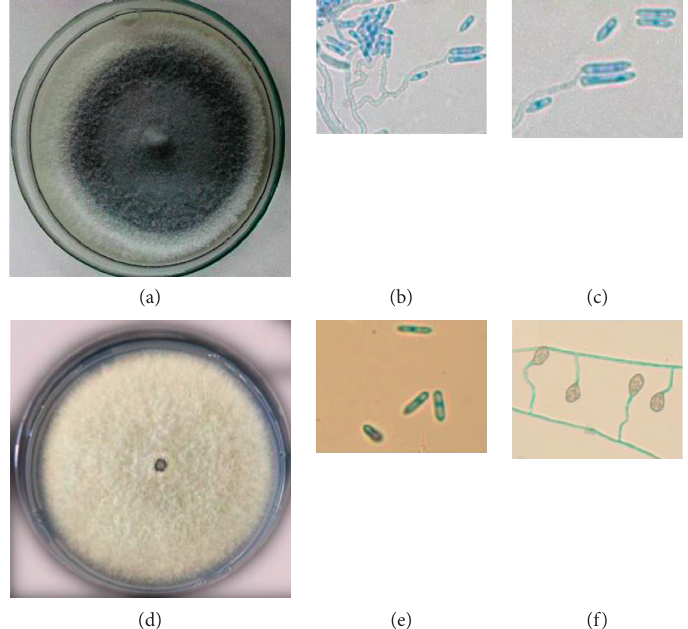
Figure 1: Morphology of the microorganisms used. (a) Morphology of the Colletotrichum siamense colony on potato dextrose agar (PDA). (b, c) Hyphae and conidia of C. siamense . (d) Morphology of the C. fructicola colony on PDA. (e, f) Conidia, hyphae, and appressoria of C. fructicola .